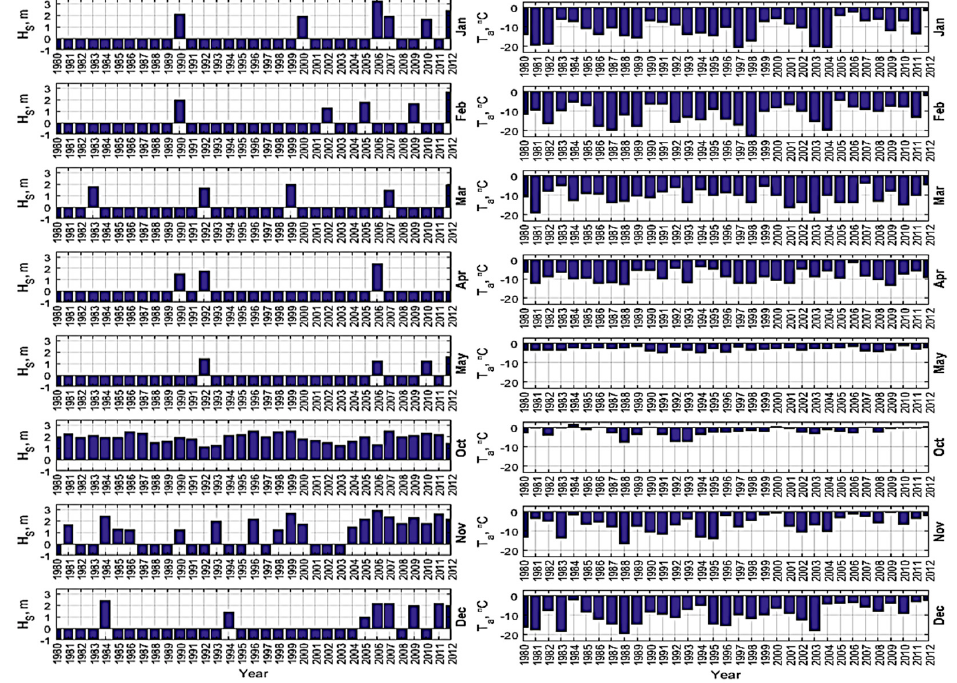
Figure 11. Yearly profile of the median of significant wave height and mean of air temperature from January to May and October to December for location X specified in Figure 10.